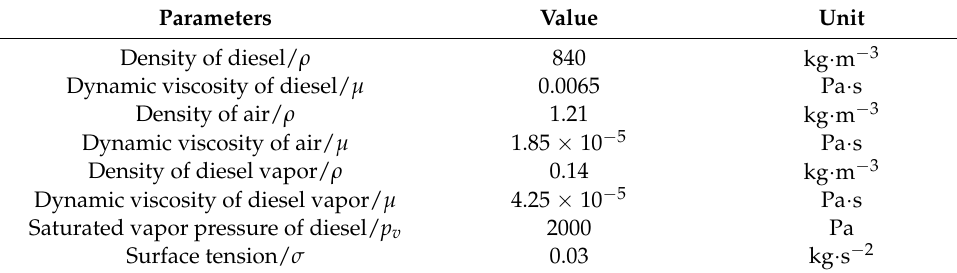
Figure 4. Volume of gas ingestion under a different number of cells. Table 1. Thermophysical parameters of